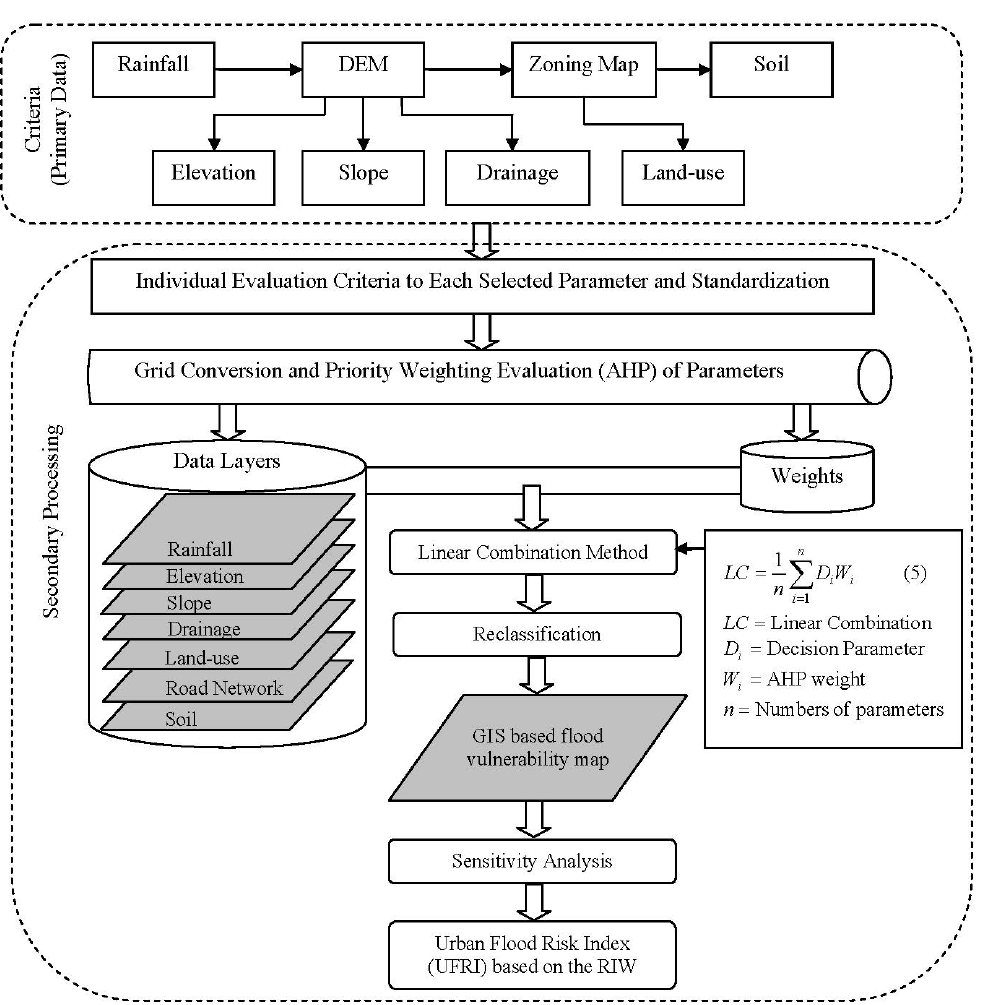
Figure 7. An MCDA conceptual framework for analytical hierarchy process-geographic information system (AHP-GIS) based urban flood mapping and flood risk analysis. The Relative Importance Weight (RIW) is the relative importance weight of the criterion on the different urban land-use